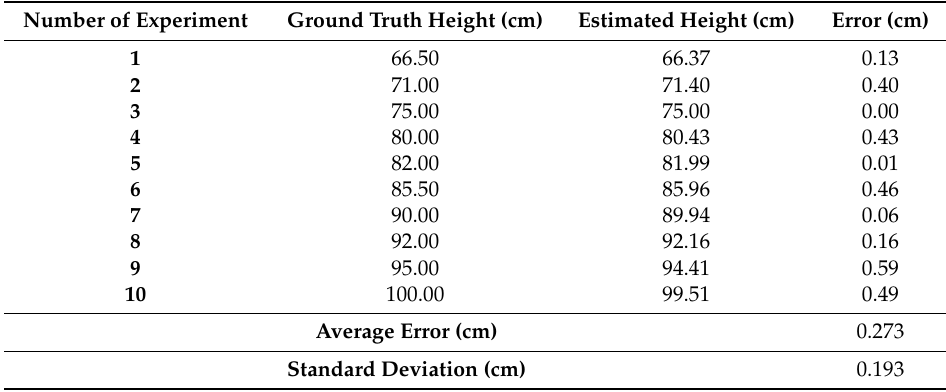
Table 1. Height estimation by the IMU.